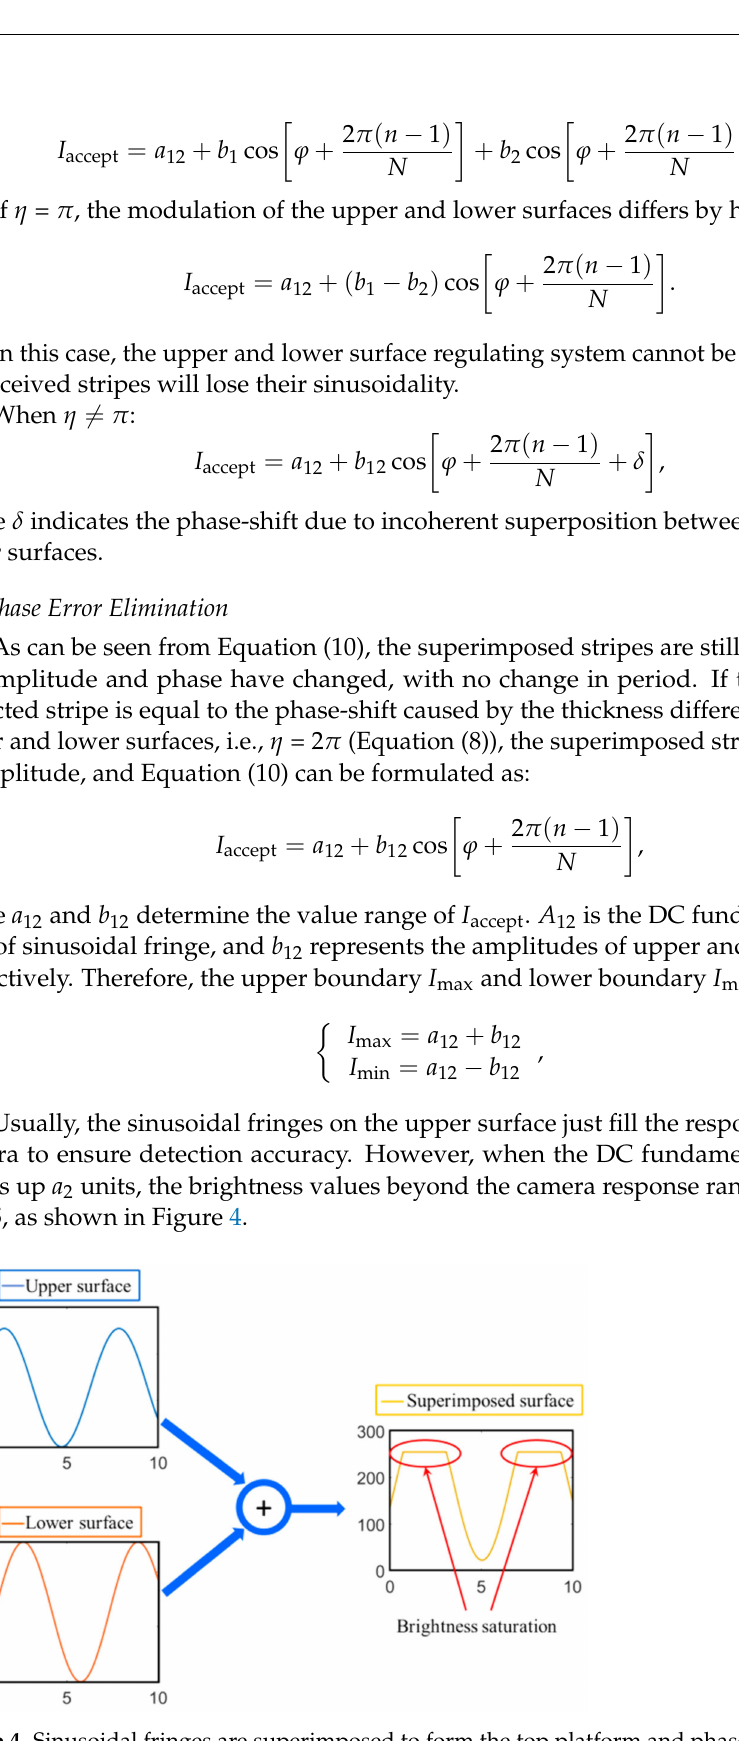
Figure 4. Sinusoidal fringes are superimposed to form the top platform and phase mutation